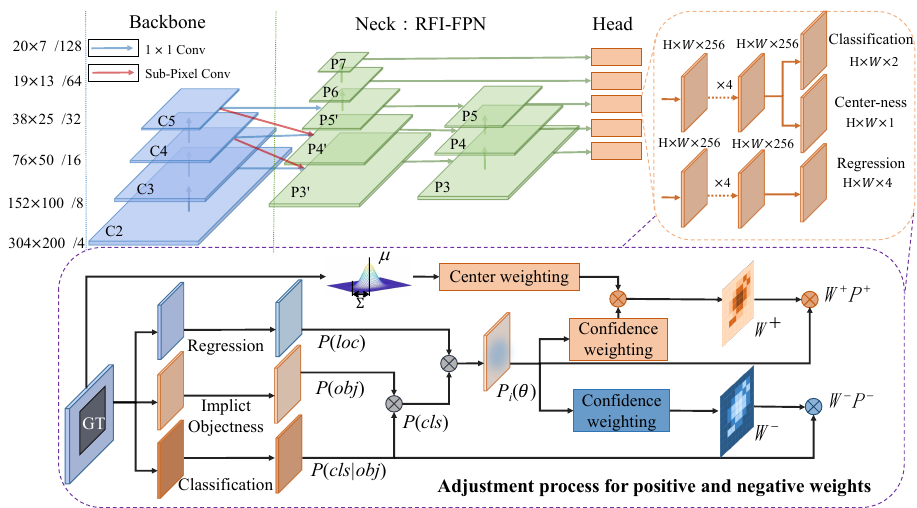
Figure 3. Detection architecture for label adaptive allocation based on real feature information enhancement.